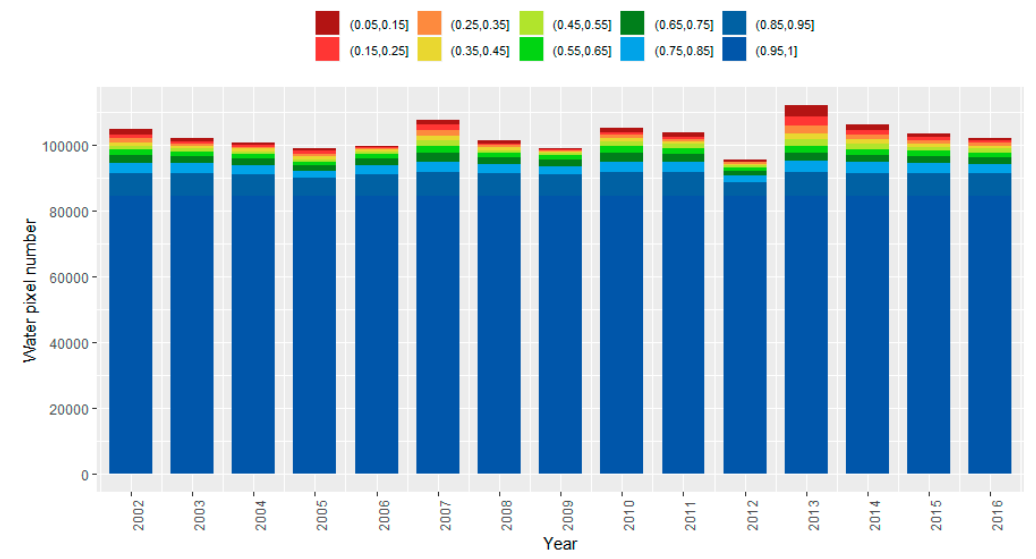
Figure 5. Distribution of pixel number of ten water frequency levels for each year during 2002–2016.